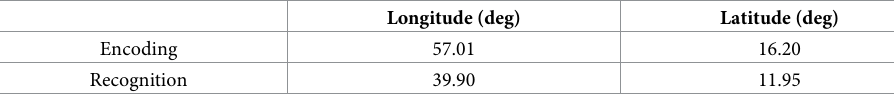
Table 3. Spreads (median standard deviations) of head